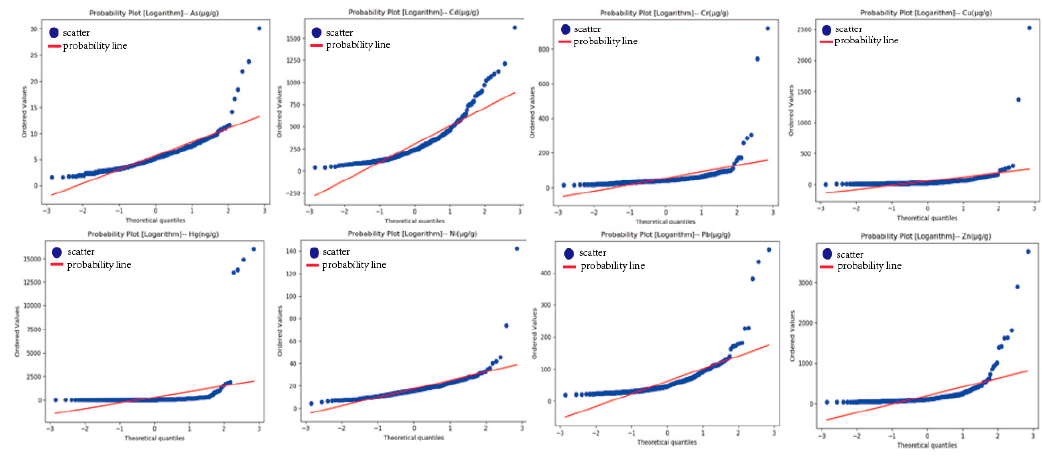
Figure 4. Probability plots.